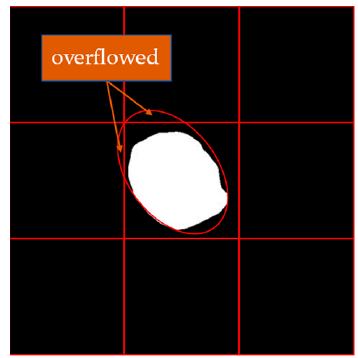
Figure 4. The schematic of fi lling pixels.